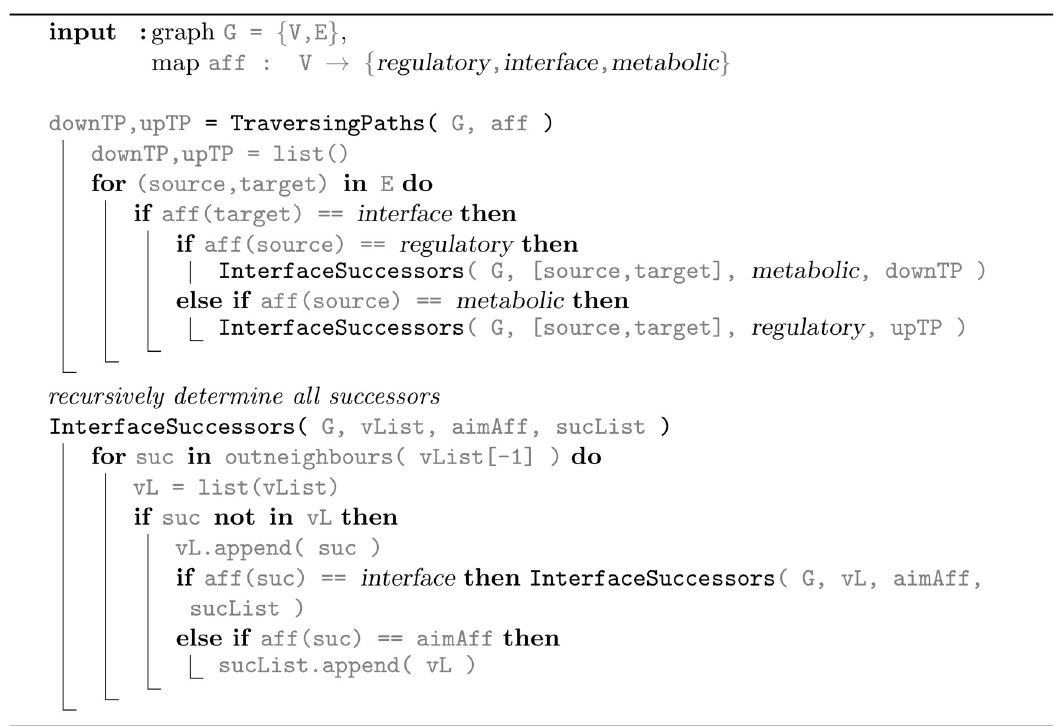
Fig 12. Algorithm 3. Recursive algorithm for the determination of the, so-termed, domain-traversing paths from regulatory to metabolic domain and vice versa truly passing the interface domain.